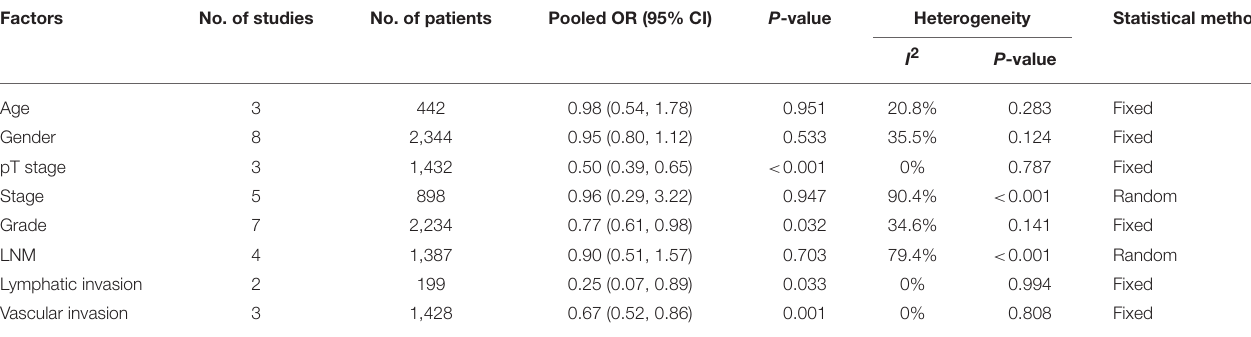
TABLE 2 | Association between high FoxP3 + Tregs infiltration and characteristics of patients with CRC.